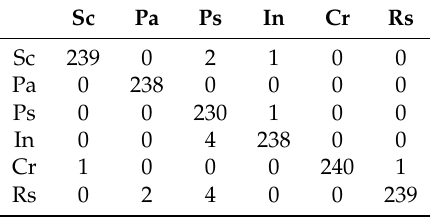
Table 1. Confusion metrics of Concurrent Convolutional Neural Network (ConCNN) (20% training data). Sc Pa Ps In Cr